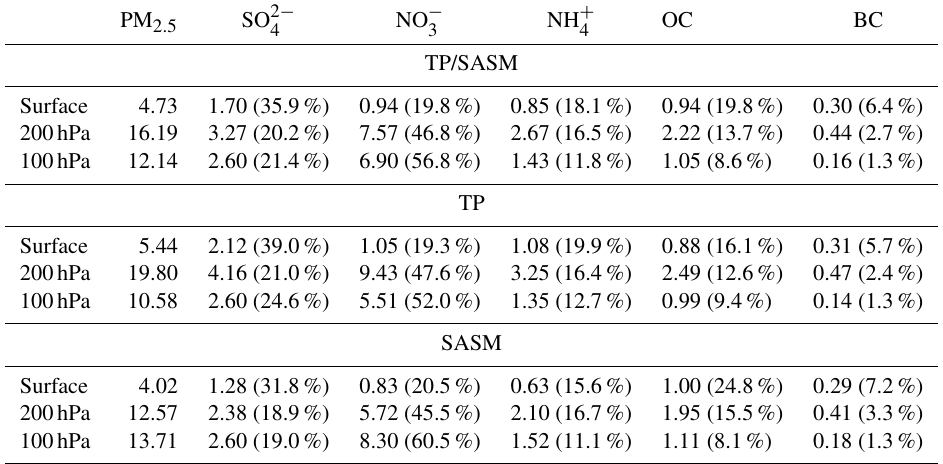
Figure 9. (a) Monthly mean distribution of aerosol extinction coefficients (km − 1 ) at 100hPa for July of 2005. (b) Monthly mean ver- tical distributions of aerosol extinction coefficients (at 525nm for SAGE II and 550nm for GEOS-Chem, with the contributions of both anthropogenic and natural aerosols considered) (km − 1 ) averaged over the Asian monsoon anticyclone region (20–120 ◦ E, 10–40 ◦ N) for July of 2005. The horizontal dashed line represents the tropopause averaged over the Asian monsoon anticyclone region simulated by the GEOS-Chem model. Table 2. Simulated seasonal mean concentrations of aerosols and their contributions to PM 2 . 5 (in percentages in parentheses) during summer- time (June–August) of 2005 for the TP/SASM, TP, and SASM regions. The unit is µgm − 3 for concentrations at the surface, and 10 − 2 µgm − 3 for concentrations at 200 and